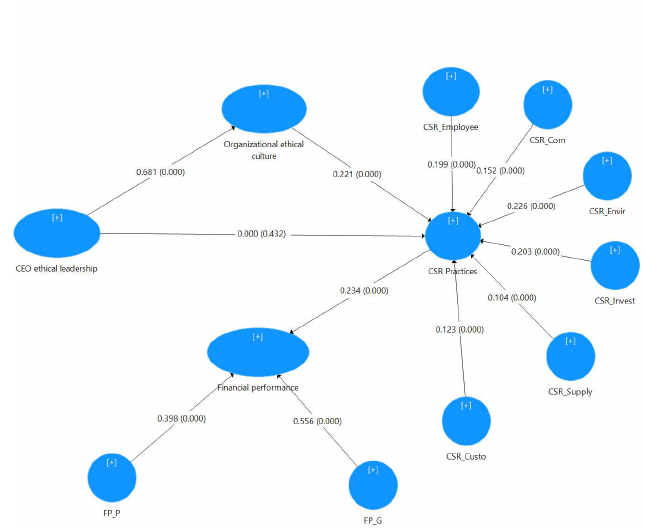
Fig. 2: Bootstrap result (PLS out)